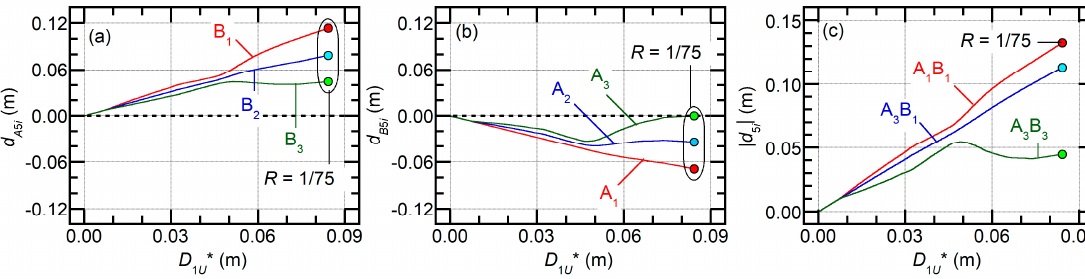
Figure 17. Roof displacement responses based on the pushover analysis: ( a ) frames B 1 to B 3 , ( b ) frames A 1 to A 3 , and ( c ) columns A 1 B 1 , A 3 B 1 , and A 3 B 3 .